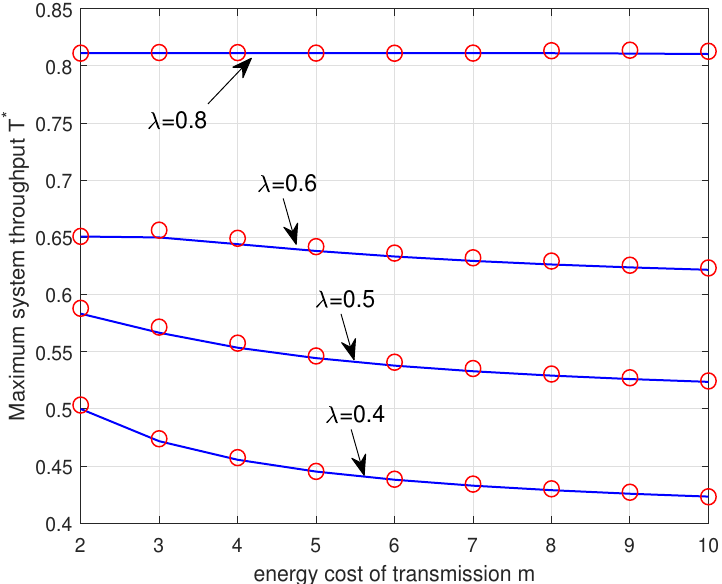
Figure 8. Maximum system throughput T ∗ (given by the Corollary 1) versus the energy cost of transmission m for different λ = 0.4, 0.5, 0.6, 0.8. The analytical results and the simulation results are plotted in solid lines and ‘ ◦ ’ markers,